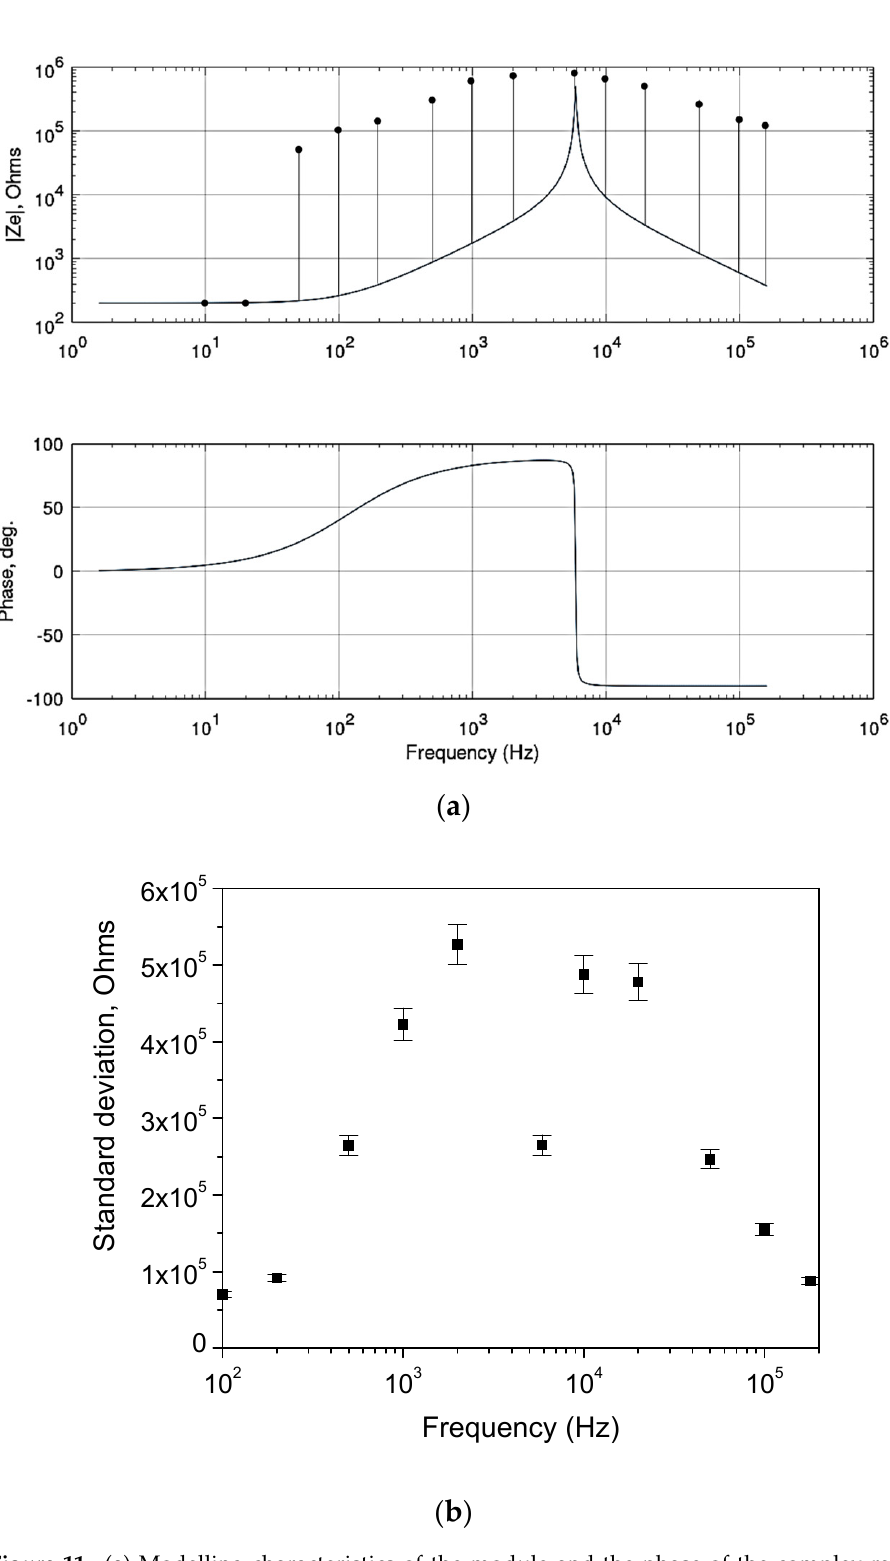
Figure 11. ( a ) Modelling characteristics of the module and the phase of the complex resistance for the equivalent circuit shown in Figure 10; ( b ) standard deviation between experimental and modelled curves.